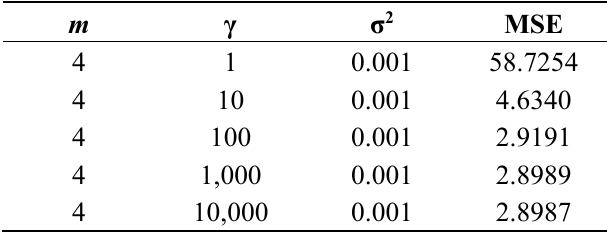
Table 2. The influence of γ on prediction precision.